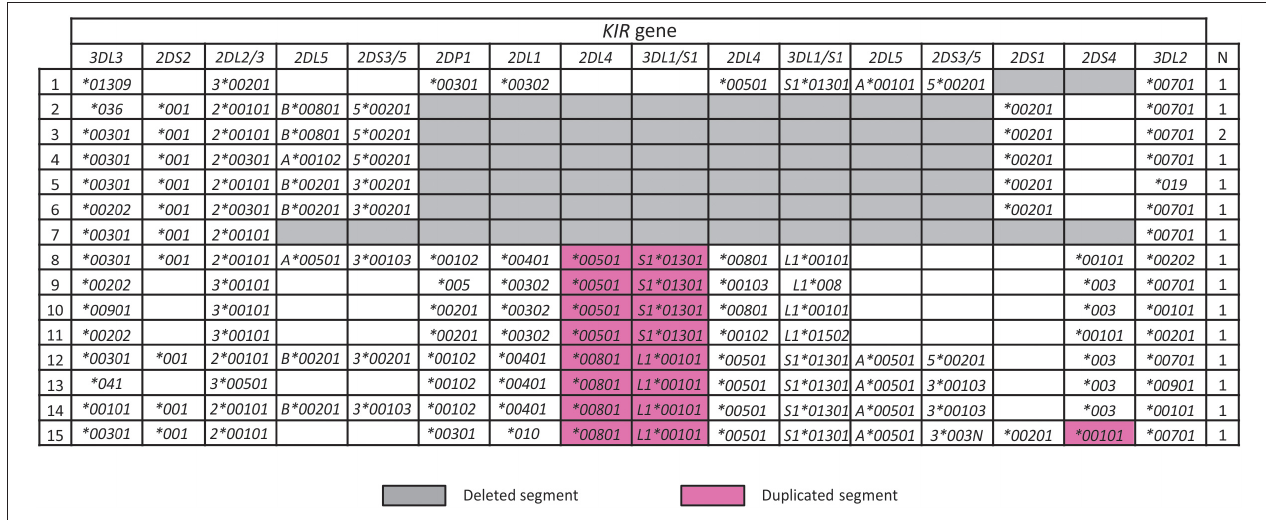
FIGURE 4 | Rare structural variants of KIR haplotypes in Iranians. Shown are Iranian KIR haplotypes affected by a copy number variation. Gray and purple boxes highlight deleted or duplicated segments, respectively. “ N ” indicates the number